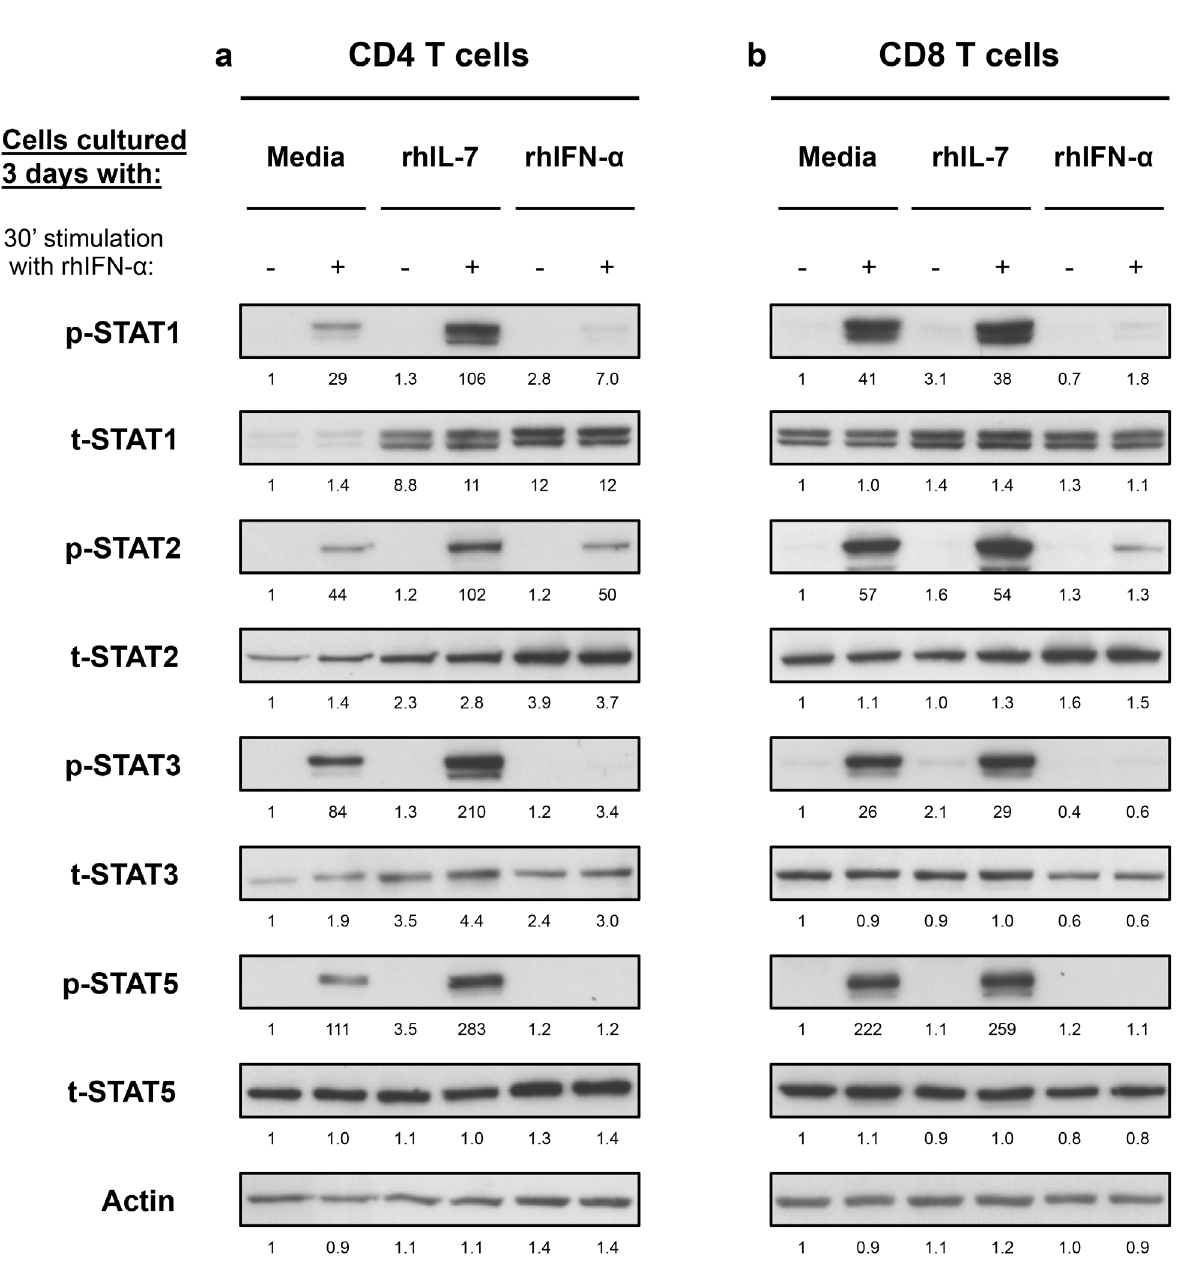
Figure 3. Invitro culture with IL-7 increases IFN- a -induced activation of STAT1, STAT2 and STAT3 in CD4 but not CD8 T cells. Isolated CD4 ( a ) and CD8 ( b ) T cells from a healthy donor were cultured and treated as described in Figure 2. Cell lysates were analyzed by Western blotting with antibodies specific to p-STAT1, t-STAT1, p-STAT2, t-STAT2, p-STAT3, t-STAT3, p-STAT5 and t-STAT5. An antibody to actin was used to confirm even protein loading. Numbers represent the ratio of the densitometry values of band densities on western blots calculated using the values of the unstimulated cells cultured for 3 days with media only as the baselines. Results are representative of at least 3 different donors.